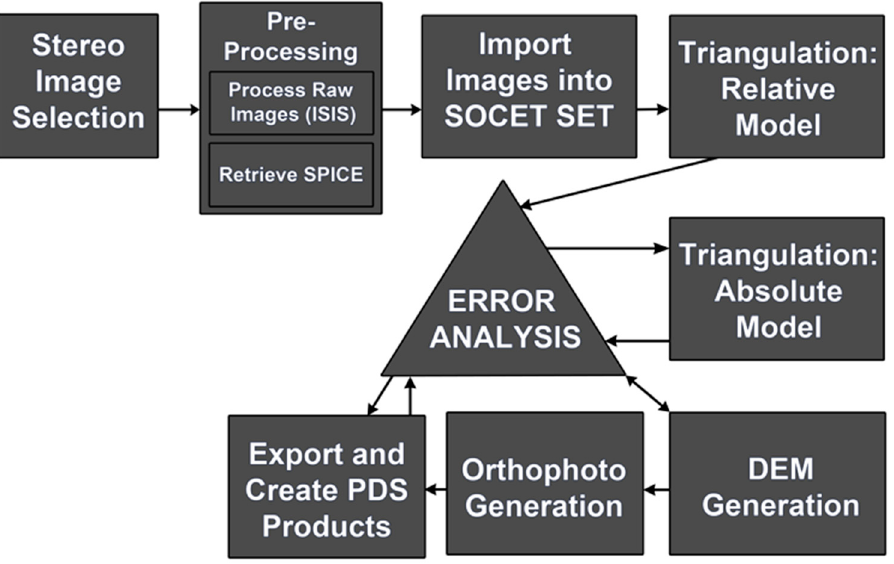
Figure 1. Workflow diagram for processing MESSENGER high-resolution stereo pairs to DEMs (adapted from Henriksen et al. [21]).